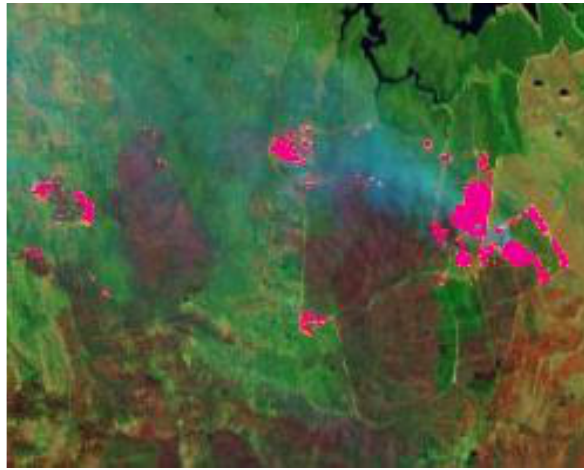
Figure 8. Real-time Landsat 8 fire mask for fires near Adelaide,